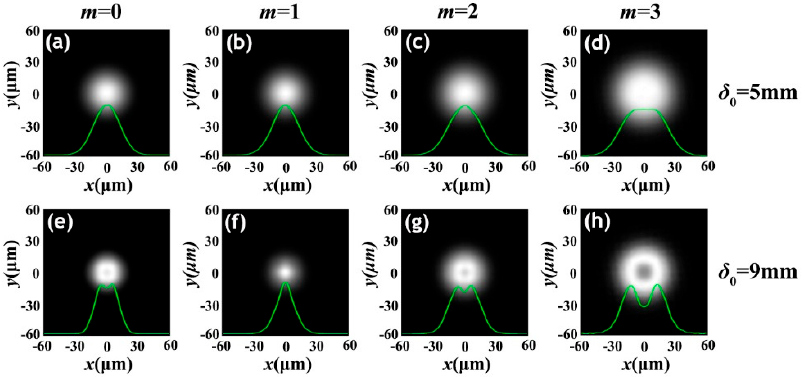
Figure 2. Distribution of the intensity of PCRP vortex beams in plane B for different coherence length and topological charge.